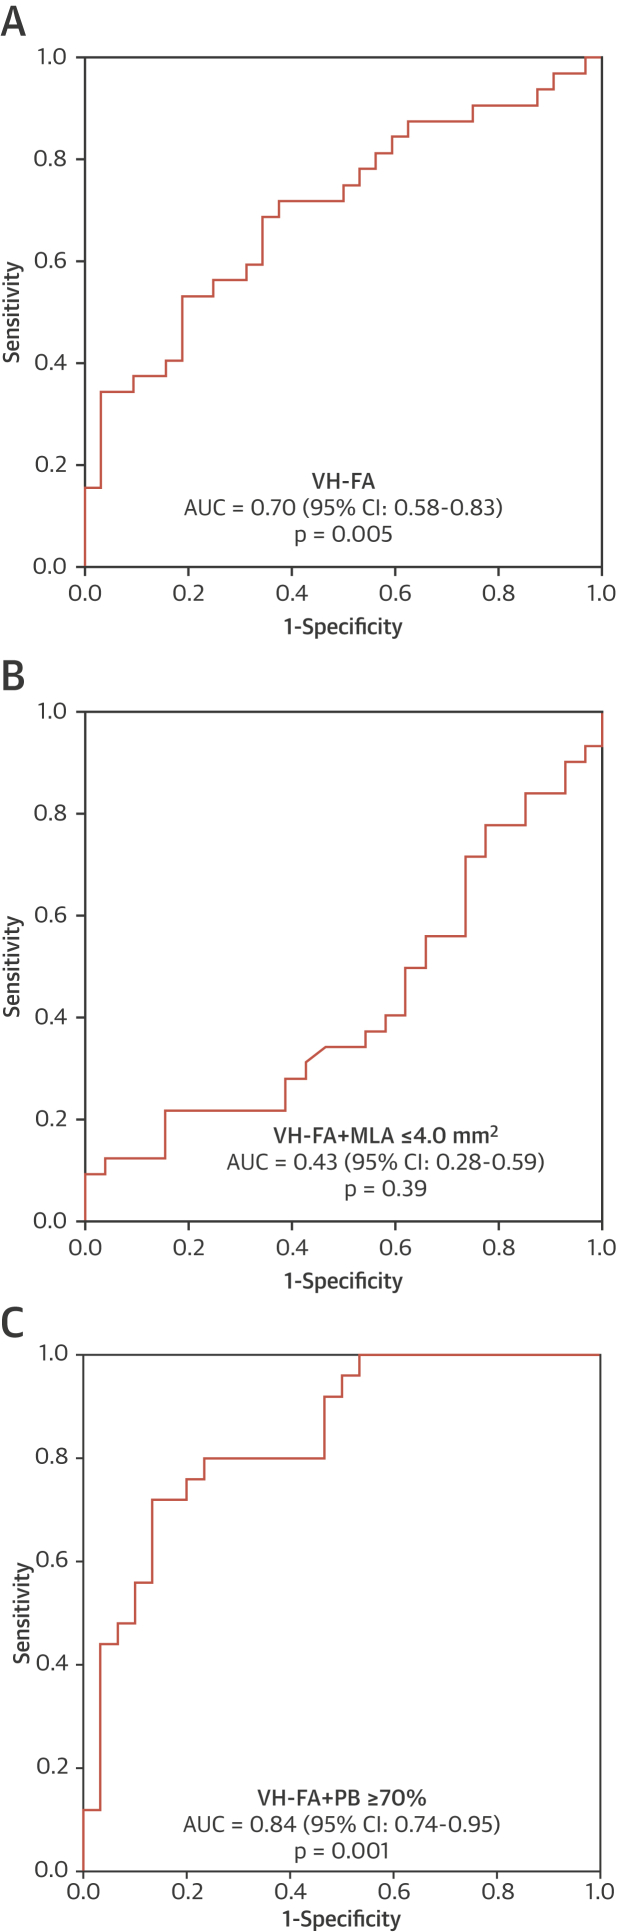
ROC Curves Illustrating the Discriminatory Power of PSS to Identify Plaque Rupture(A) ROC curve for PSS in VH-FA. (B) ROC curve for PSS in VH-FA + MLA ≤4 mm2. (C) ROC curve for PSS in VH-FA+PB ≥70%. AUC = area under the curve; CI = confidence interval; MLA = minimal lumen area; PB = plaque burden; ROC = receiver-operating characteristic; other abbreviation as in Figure 1.